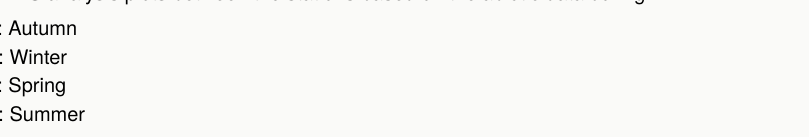
Figure 4. nMDS analysis plots between the stations based on the abiotic data